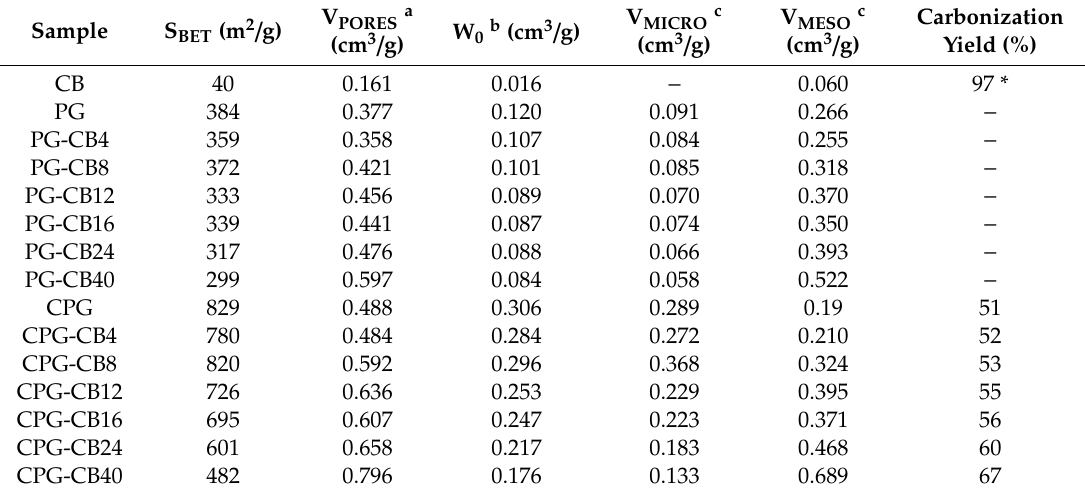
Table 1. Carbonization yield and main textural parameters obtained from the N 2 adsorption isotherms for the materials synthesized with di ff erent amounts of CB